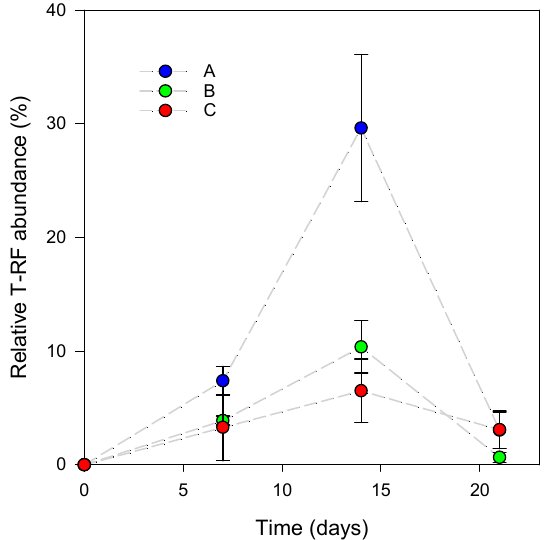
Figure 1. Relative abundance (%) of an L. reuteri DSM 17938 restriction fragment during the experiment for each subject (A, B, C). Error bars represent the standard deviation of the mean ( n = 3).